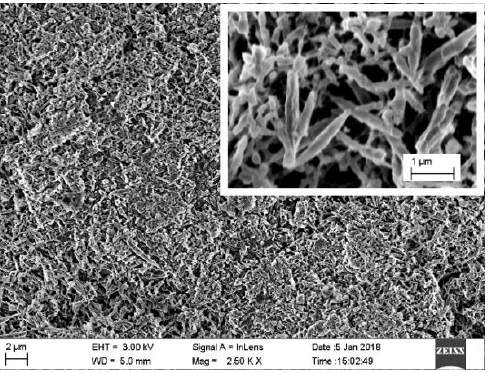
Figure 1. Scanning electron micrograph of poly(acrylic acid/chestnut shell pigment).